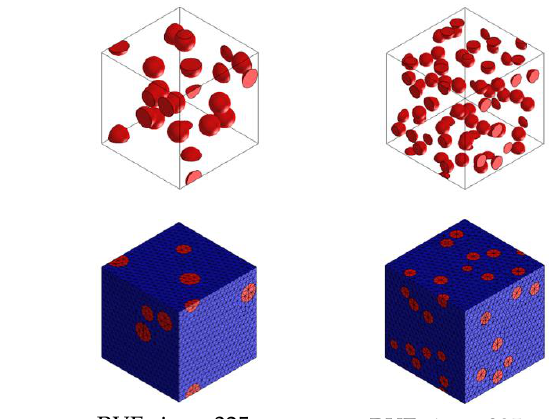
Figure 7. Four difference size RVEs and corresponding mesh models.